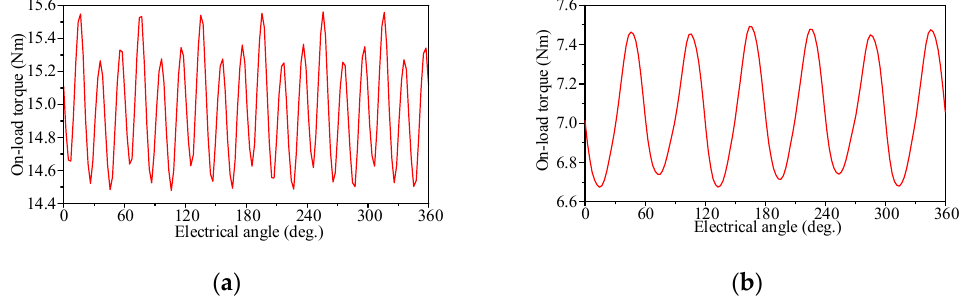
Figure 12. On-load torque of two modes. ( a ) 8-pole mode. ( b ) 24-pole mode.